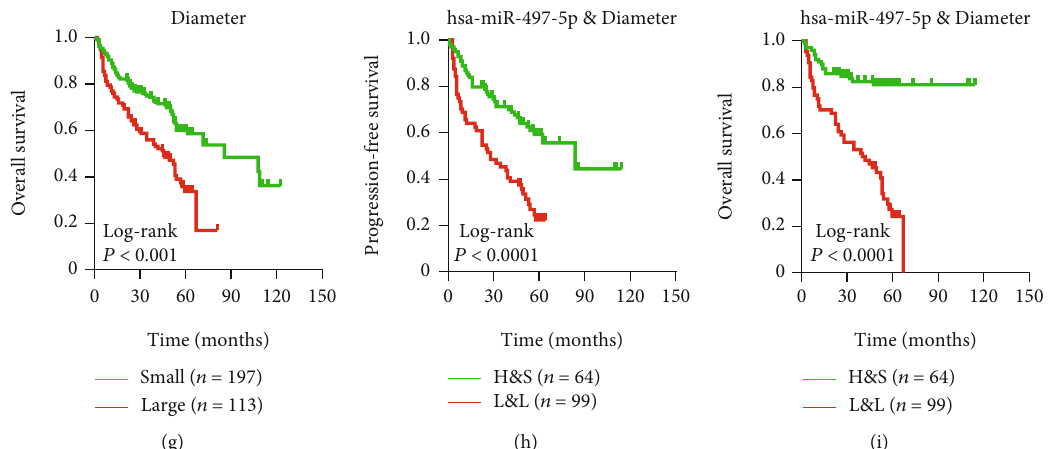
Figure 5: Association between miR-497-5p expression and clinical features with HCC prognosis. (a) The expression levels of miR-497-5p were signi fi cantly downregulated contrasted with adjacent noncancerous tissues. (b) A signi fi cantly lower miR-497-5p in human HCC specimens compared with adjacent noncancerous specimens. (c) Pearson correlation miR-497-5p in HCC tumor tissues in contrast with adjacent normal tissues. (d, e) Lower miR-497-5p expression was signi fi cantly correlated with poor PFS (d) and OS (e). (f, g) Tumor diameter was signi fi cantly correlated with decreased duration of PFS (f) and OS (g) of patients with HCC. (h, i) Patients with low miR- 497-5p levels and large tumor diameter ( ≥ 5 cm) were associated with shorter PFS (h) and OS